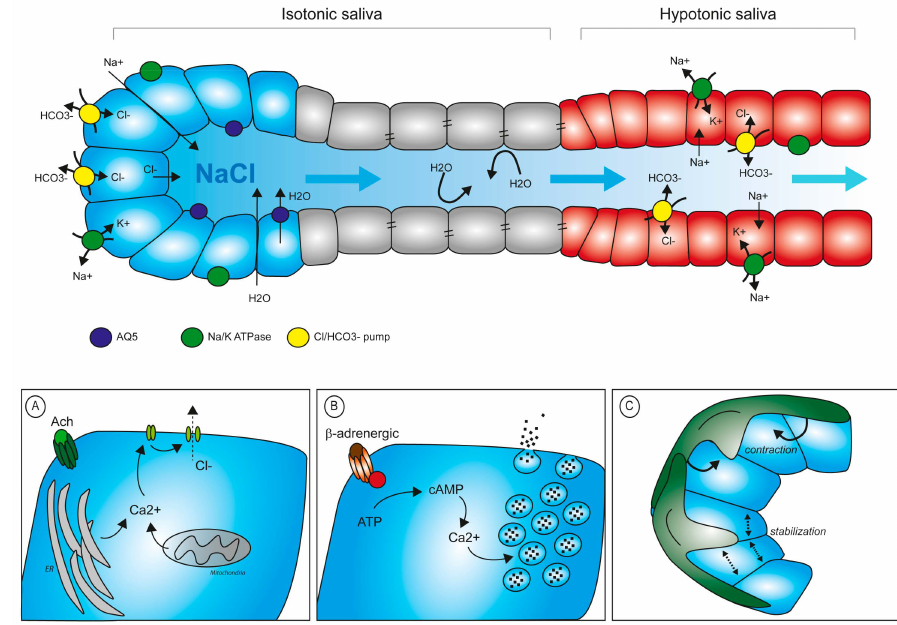
Figure 3. Saliva production and regulation of secretion. Composition of primary saliva and its progressive conversion into a hypotonic fluid. Primary saliva is rich in electrolytes which attract water into the lumen. In a secondary step, electrolytes are resorbed via the epithelial duct cells to reduce their concentration in the saliva before release in the oral cavity. ( A ) Schematic representation of intracellular Ca 2 + control levels upon muscarinic stimuli. ( B ) Secretion of proteins into the lumen requires Ca 2 + -mediated degranulation upon β -adrenergic stimulation. ( C ) Myoepithelial cells participate in the mechanical contraction stimulating secretion and in the stabilization of acinar structure during the resting